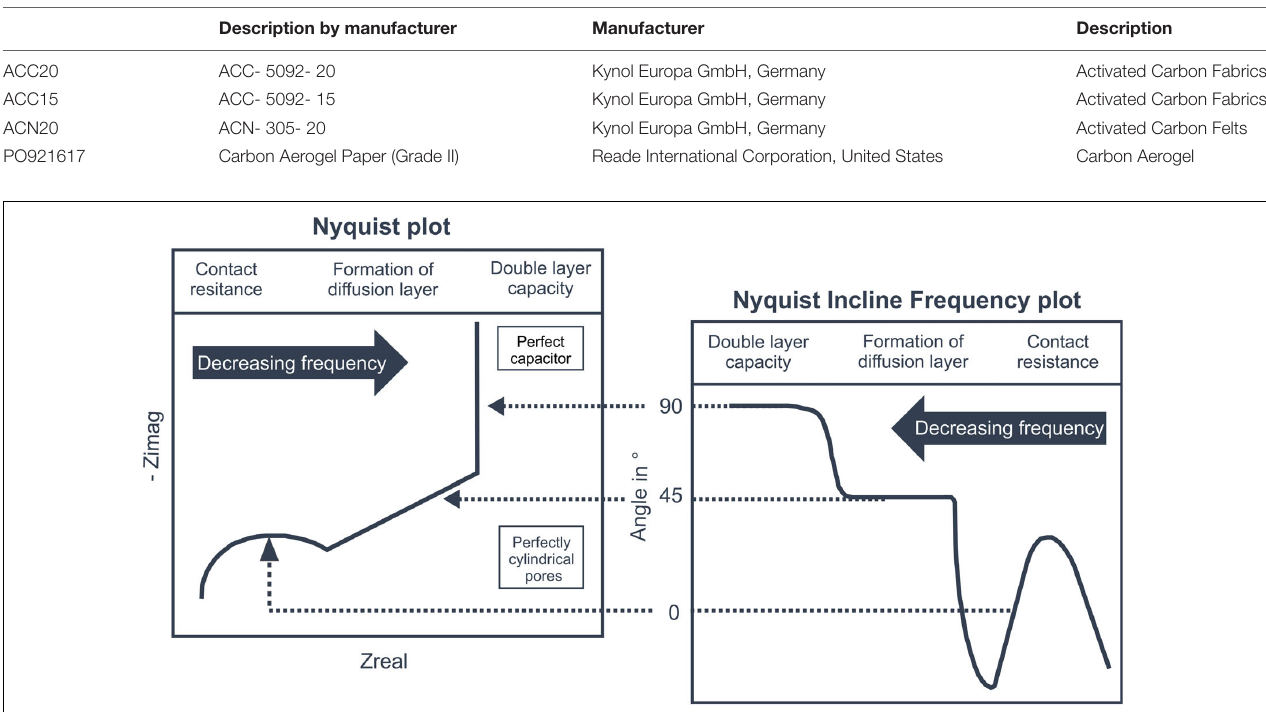
TABLE 1 | Description and manufacturer of the electrode materials.